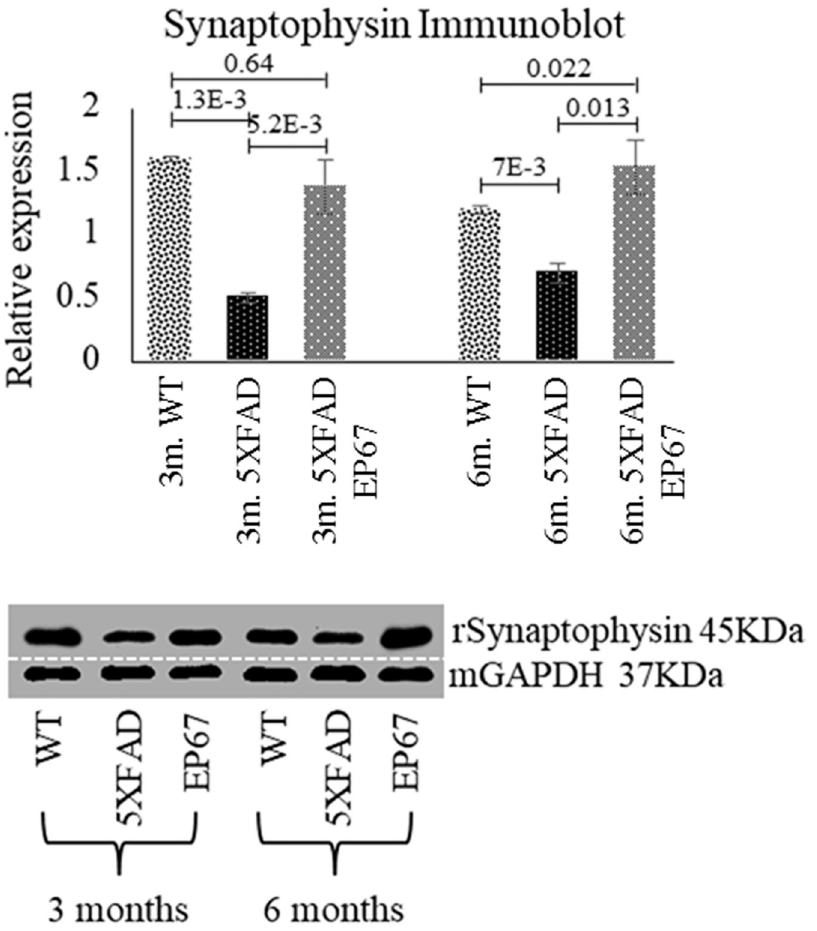
Fig 6. Synaptophysin immunoblot. Immunoblots against synaptophysin were prepared. n = 6/group/age. Mean ± 1SD. (Immunoblot images indicate representative sample runs and were cropped as indicated by the dotted white